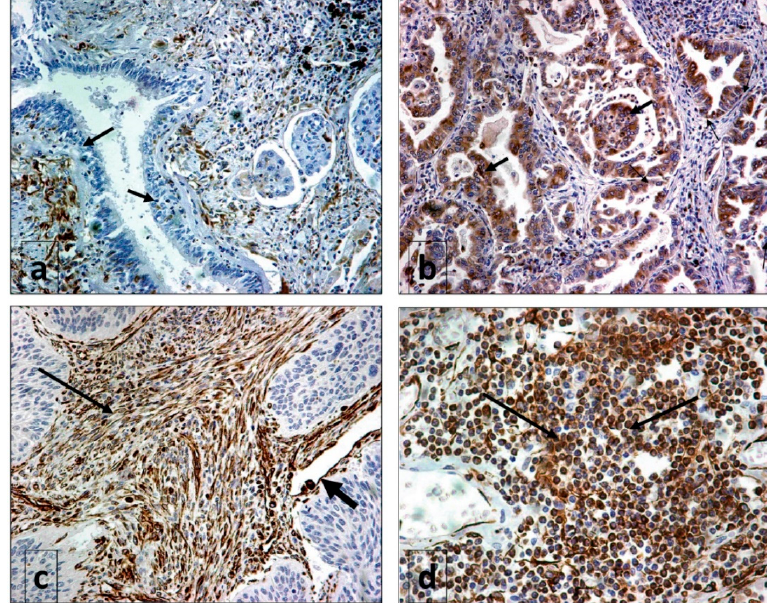
Figure 1. Typical immunohistochemical images of Inducible Nitric Oxygen Synthase (iNOS) expression: ( a ) lack of expression in bronchial epithelium (arrows) (magnification × 20); ( b ) strong cytoplasmic expression by cancer cells (arrows) (magnification × 20); ( c ) strong expression by stroma fibroblasts (thin arrow) and a tumor vessel (thick arrow) in the context of negative cancer cell expression (magnification × 40); ( d ) extensive infiltration of the tumor stroma by iNOS-expressing lymphocytes (arrows) (magnification ×